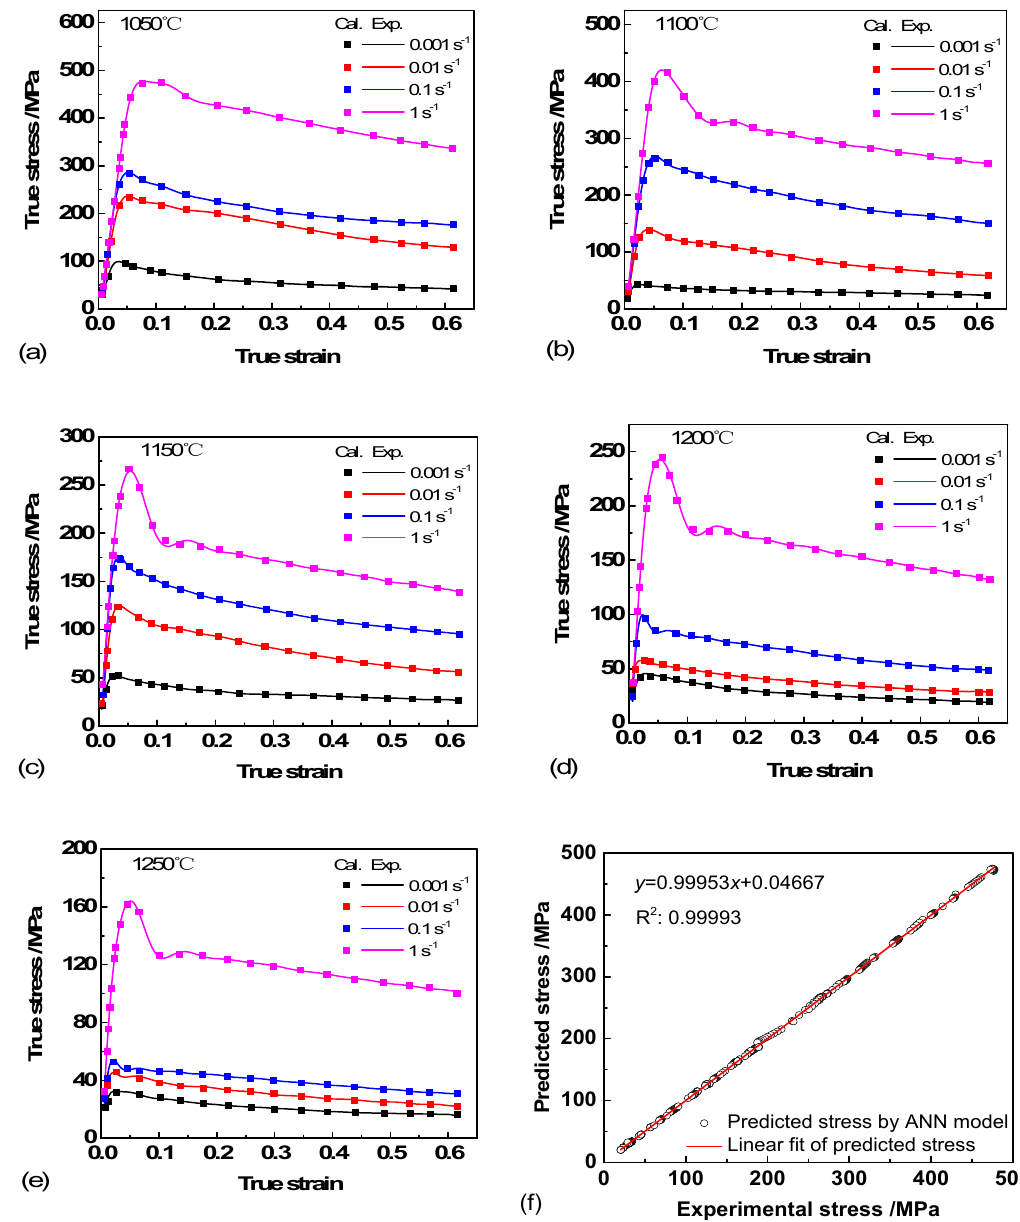
Figure 6. Comparison of the experimental and predicted data of Ti-44Al-5Nb-1Mo-2V-0.2B alloy: ( a ) 1050 °C; ( b ) 1100 °C; ( c ) 1150 °C; ( d ) 1200 °C; ( e ) 1250 °C; ( f ) correlation analysis. Figure 6f is the linear regression between ANN predicted stress and 20% test experimental data.